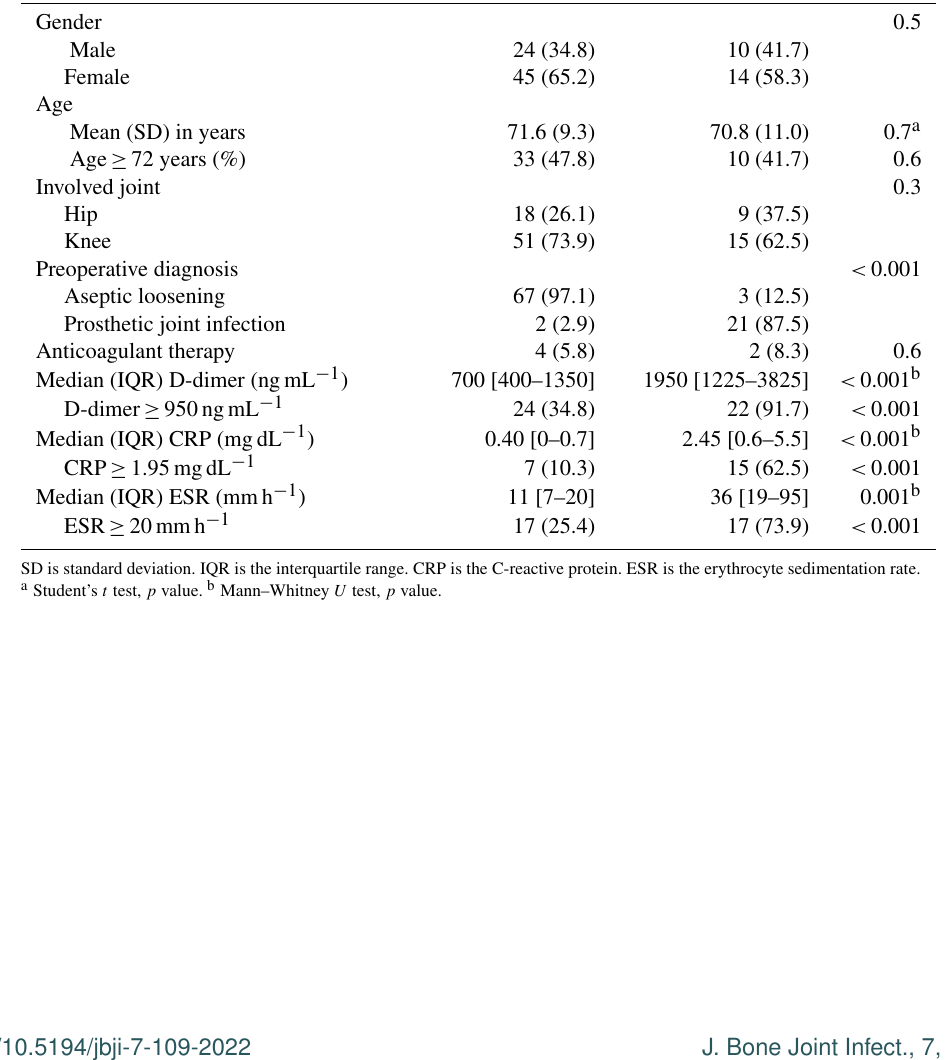
Table A1. Characteristics of patients according to the 2018 International Consensus Meeting (ICM) criteria of prosthetic joint infection (PJI). Characteristics